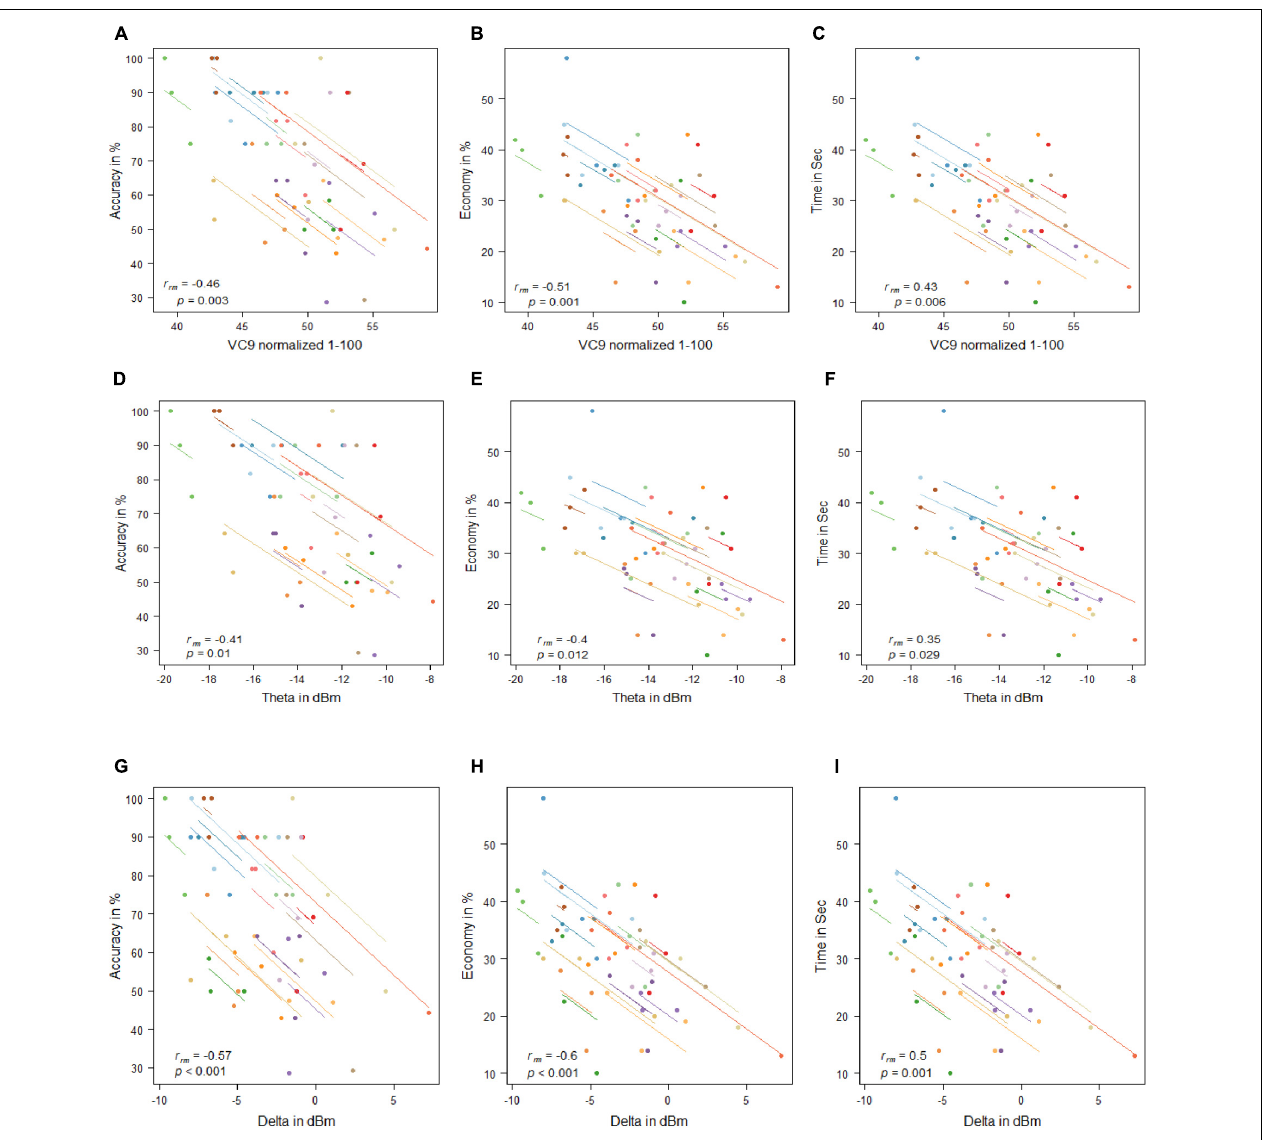
FIGURE 4 | Mean activity of VC9 as a function of accuracy (A) , economy (B) , and time (C) ; theta as a function of accuracy (D) , economy (E) , and time (F) ; and delta as a function of accuracy (G) , economy (H) , and time (I) per trial and participant obtained in Experiment 1 ( n = 19). R rm and p- values